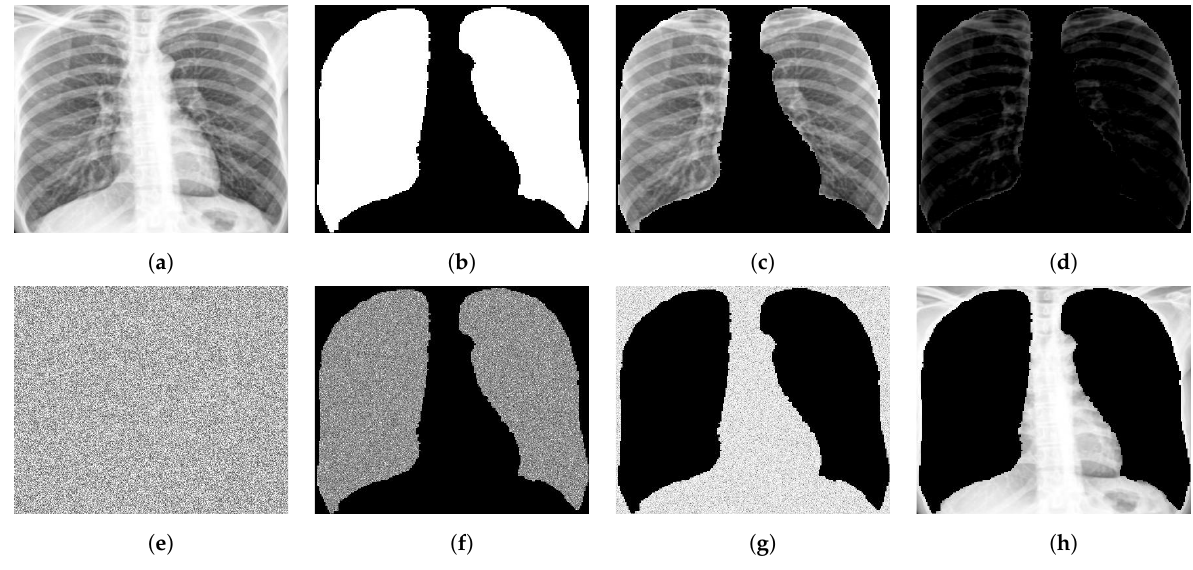
Figure 10. Different ways in which a chest X-ray image is modified to limit the information the classifier relies on. Top (left to right): ( a ) Cropped X-ray image, ( b ) lung mask, ( c ) segmented lung, ( d ) segmented lung with mean of background subtracted. Bottom (left to right): ( e ) Entire image randomized, ( f ) lung pixels randomized with non-lung area set to 0, ( g ) non-lung pixels randomized with lung pixels set to 0, and ( h ) lung pixels set to 0. Table 6. Performance with input and model